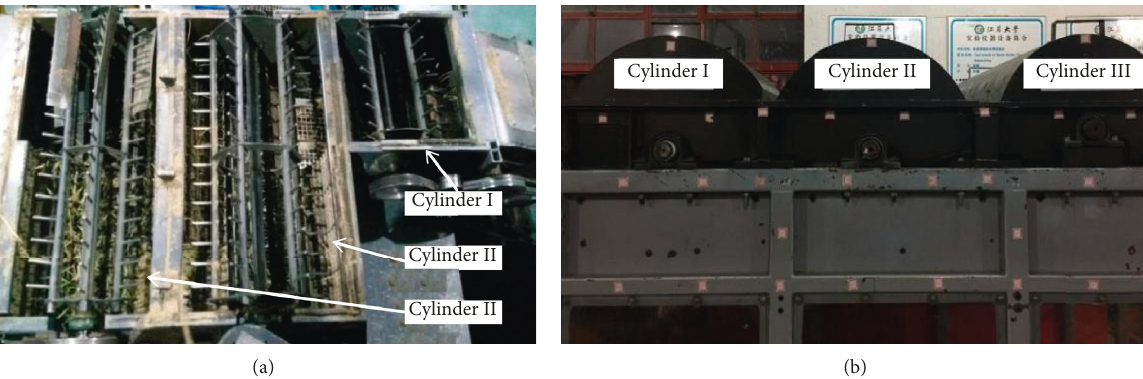
Figure 1: Co-frame multicylinder test bench. (a) The array structure of three cylinders. (b) The position relationship among the